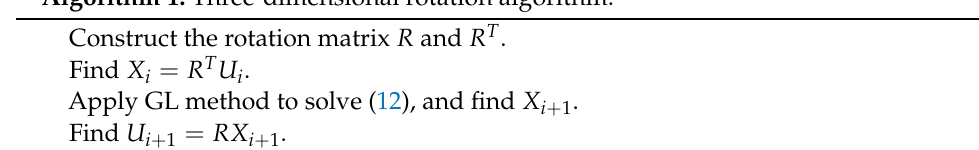
Algorithm 1: Three-dimensional rotation algorithm.